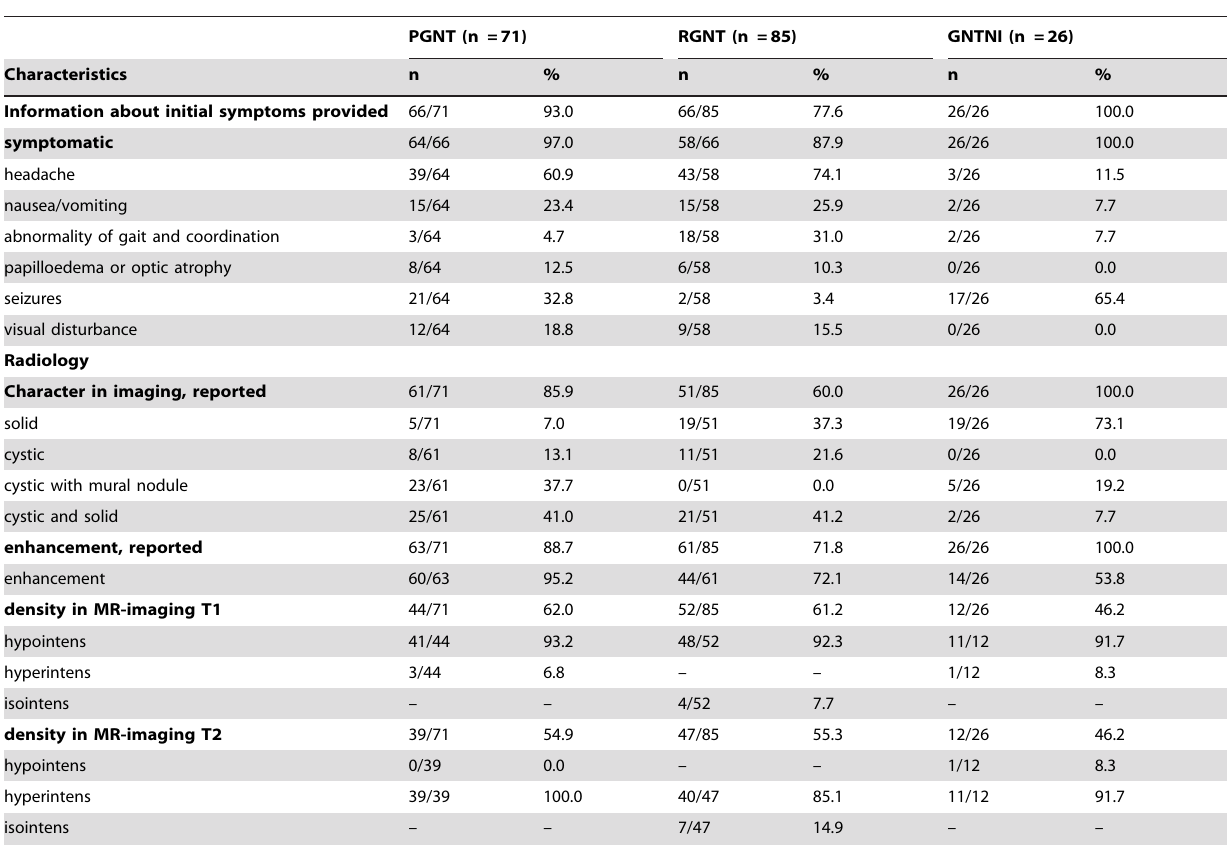
Table 3. Initial symptoms and radiology